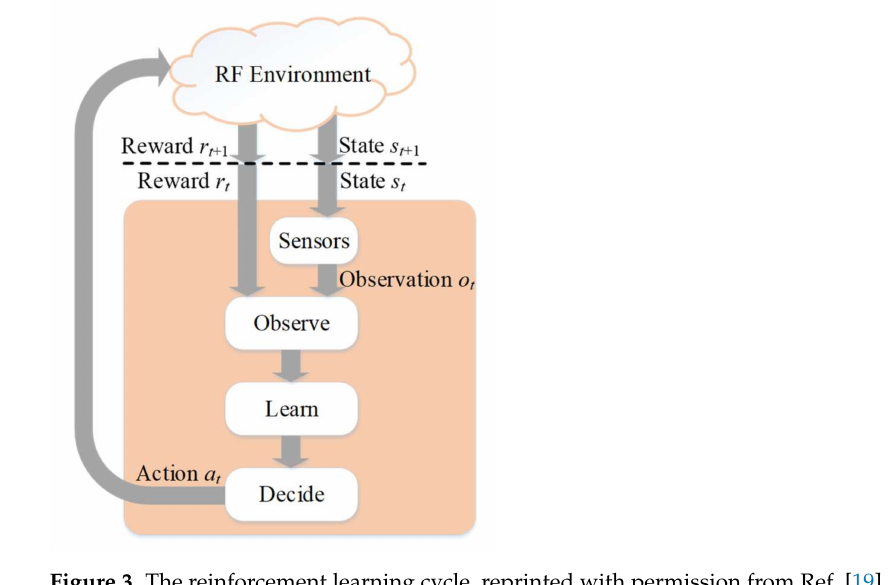
Figure 3. The reinforcement learning cycle, reprinted with permission from Ref. [19]. 2020